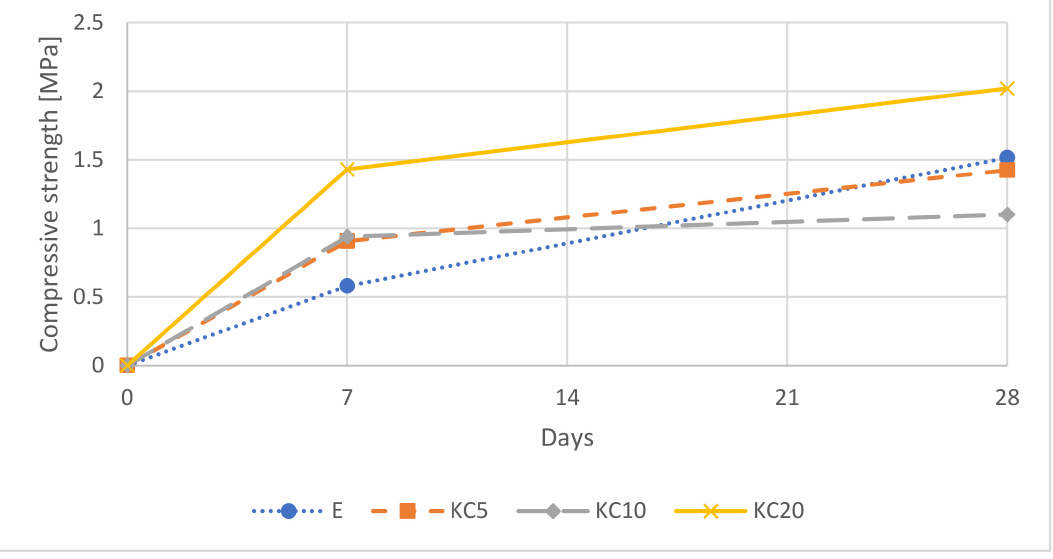
Figure 3. Development of compressive strength from 7–28 days in Series 2 (varied w/b ratio and percentage of